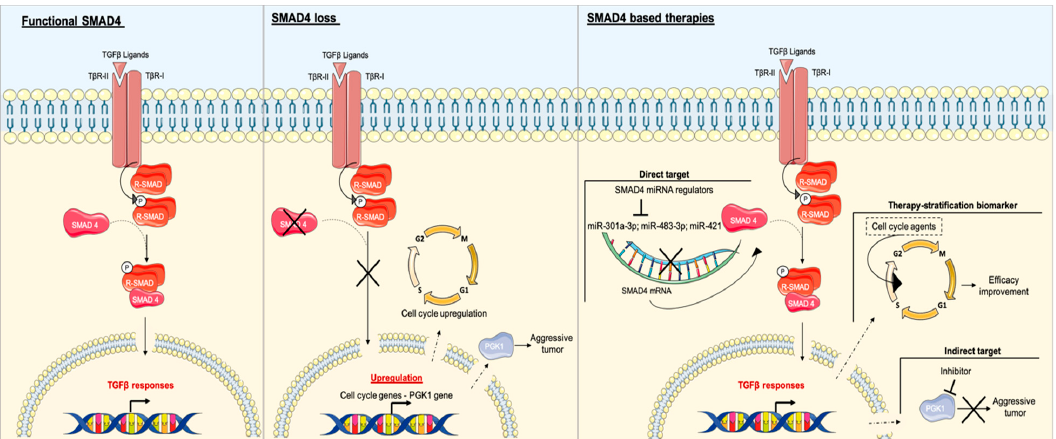
Figure 3. Effects of SMAD4 loss and potential therapeutic strategies in SMAD4 signaling. In normal cells, SMAD4 acts as an intracellular mediator of TGF β . In SMAD4-null cells, loss of SMAD4 leads to upregulation of the cell cycle and phosphoglycerate kinase 1 (PGK1), leading to tumor promotion.